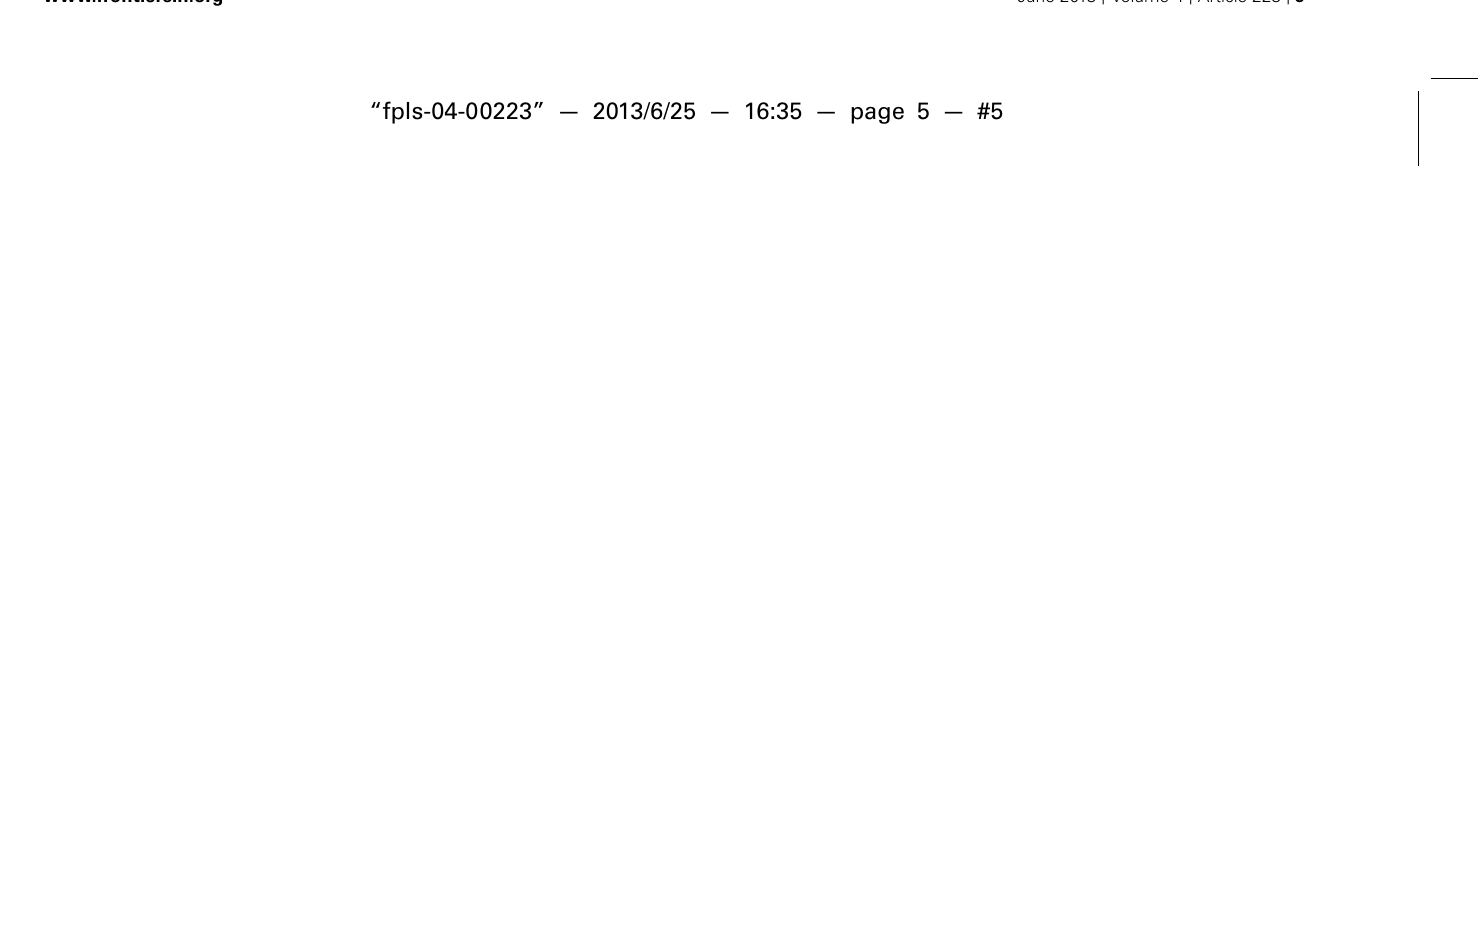
FIGURE 2 | Predicted membrane topology of the SbSUT5 protein. The predicted trans-membrane regions of the SbSUT5 transporter from sweet Sorghum (Rio), identifying which amino acids differ between cv. Rio and cv. BTx623 (red circles).Twelve trans-membrane